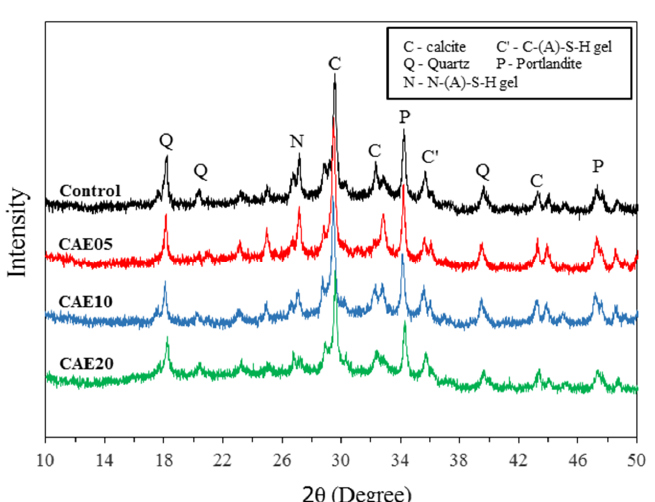
Figure 10. The XRD patterns of the hybrid alkali-activated pastes with different CAE contents.